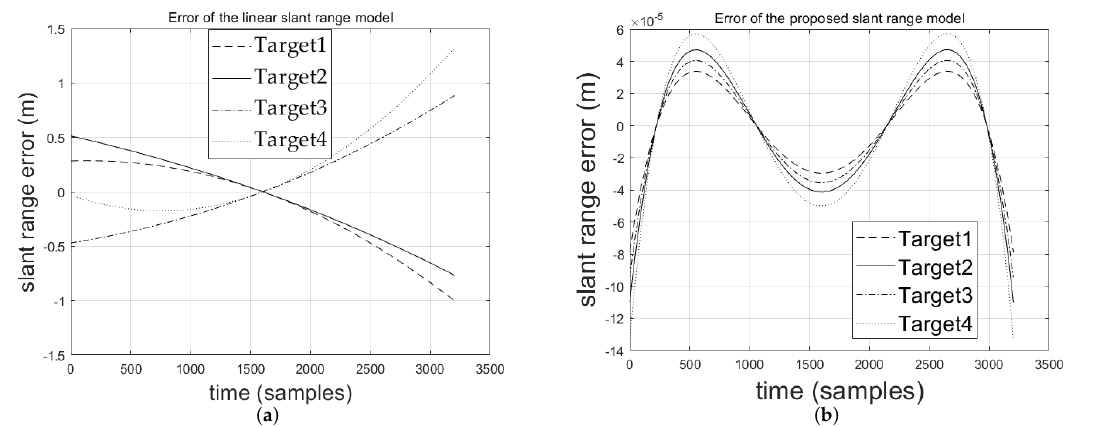
Figure 3. Slant range errors of different targets with different slant range model. ( a ) Error of the linear slant range model. ( b ) Error of the proposed slant range model.